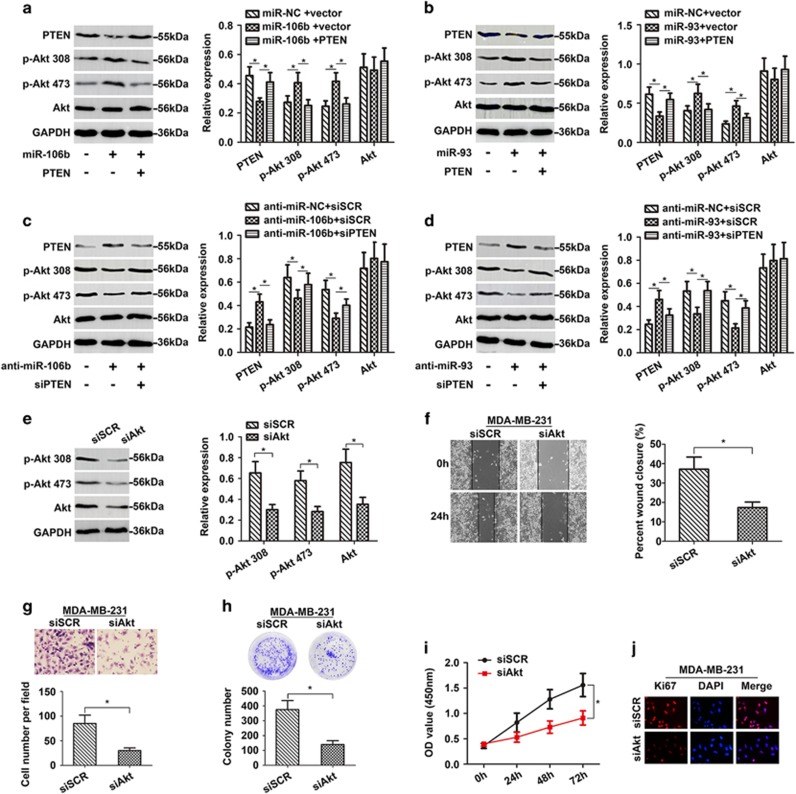
MiR-106b and miR-93 regulated the activity of PI3K/Akt pathway by suppression of PTEN. (a and b) The primary Akt protein level was measured after co-transfection with miRNA mimics (miR-NC, miR-106b mimics or miR-93 mimics) and the target mRNA (control vector or PTEN) in MCF-7 cells. (c and d) The primary Akt protein level was detected after co-transfection with anti-miRNA (anti-miR-NC, anti-miR-106b or anti-miR-93) and the target mRNA (siSCR or siPTEN) in MDA-MB-231 cells. (e) SiAkt was utilized in MDA-MB-231 cells to inhibit the expression of Akt and the primary Akt protein level was measured by western blot analysis. The capacity of cell migration, invasion and proliferation was decreased after treatment with siAkt based on the results of wound-healing (f), transwell (g), colony formation (h), CCK8 (i) and IF assays (j). Each experiment was independently repeated at least three times. Data were presented as mean±S.D. (*P<0.05)